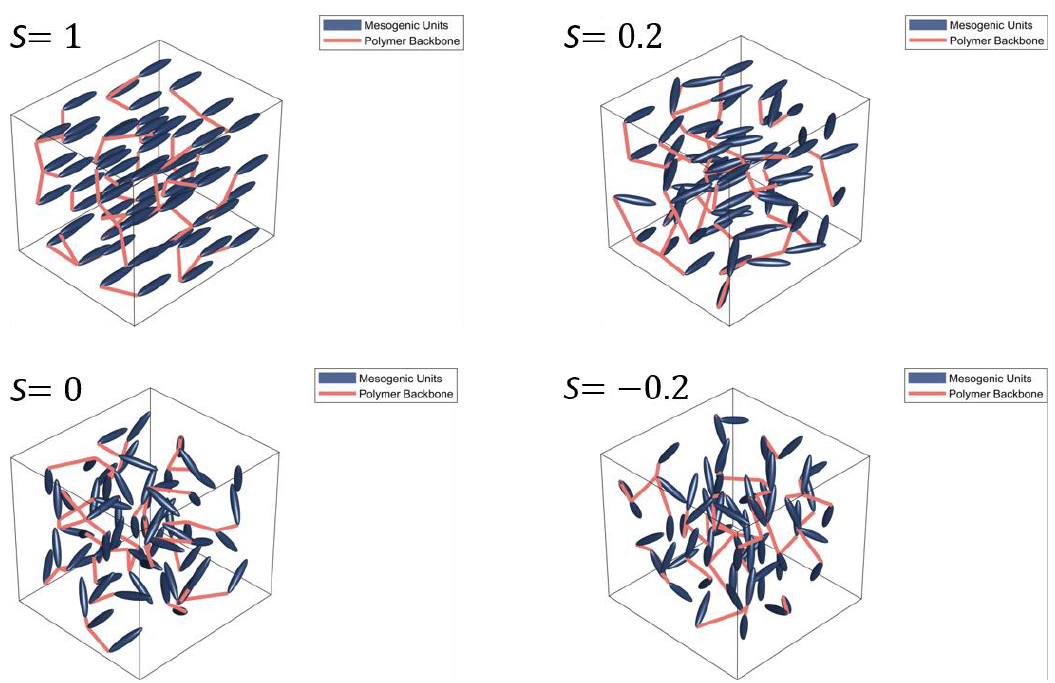
Figure 2. Schematic displaying the order of a liquid crystal polymer network. It clearly displays the impact of the order on the polymer backbone shape and orientation. Presented here are the results for a S value of S = 1, S = 0.6, S = 0, and S = − 0.2. The director, n , is parallel to the x axis. _